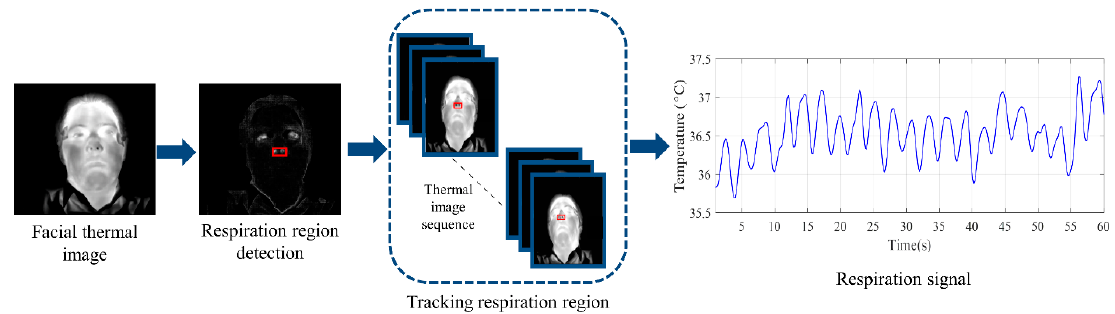
Figure 3. Respiration signal extraction procedure: First, the respiration region was extracted by cumulating temporal changes in the first few frames of the thermal sequence. Then, it was tracked in thermal image sequences, and finally, the signal was formed by calculating the mean temperature of the respiration region in each frame.